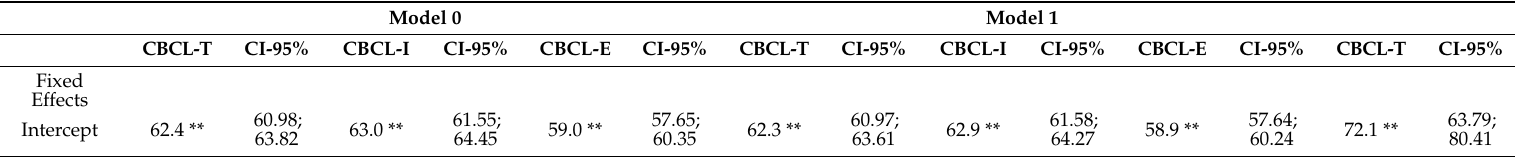
Table 4. BSI GSI (mentally ill parent) as a predictor for CBCL (children’s psychiatric symptoms). Model